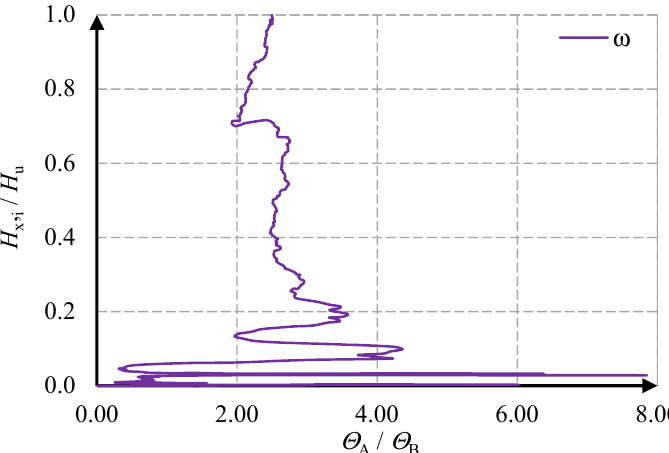
Figure 18. Relation between the H x,i / H u and Θ A / Θ B for the MB-AAC-010/2 model.